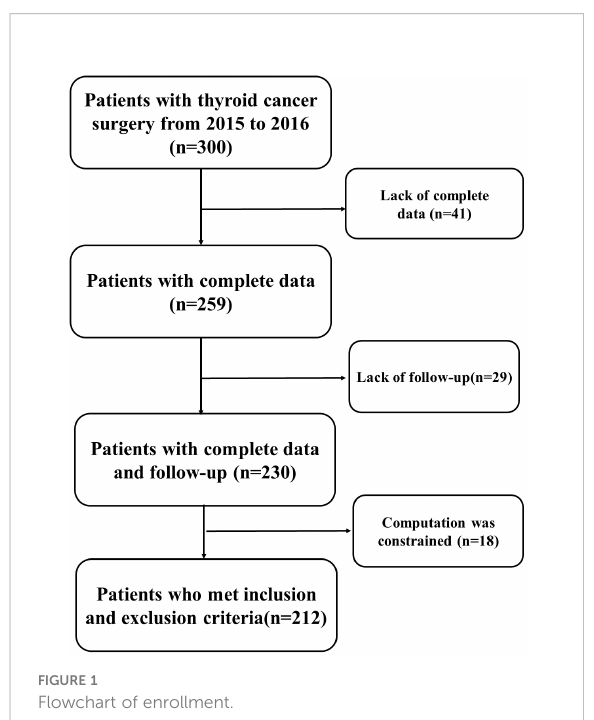
FIGURE 1 Flowchart of